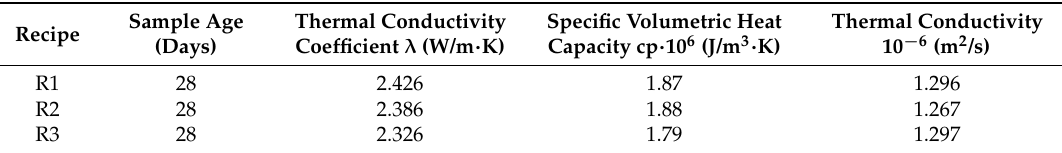
Table 4. Thermal properties of cement composites.